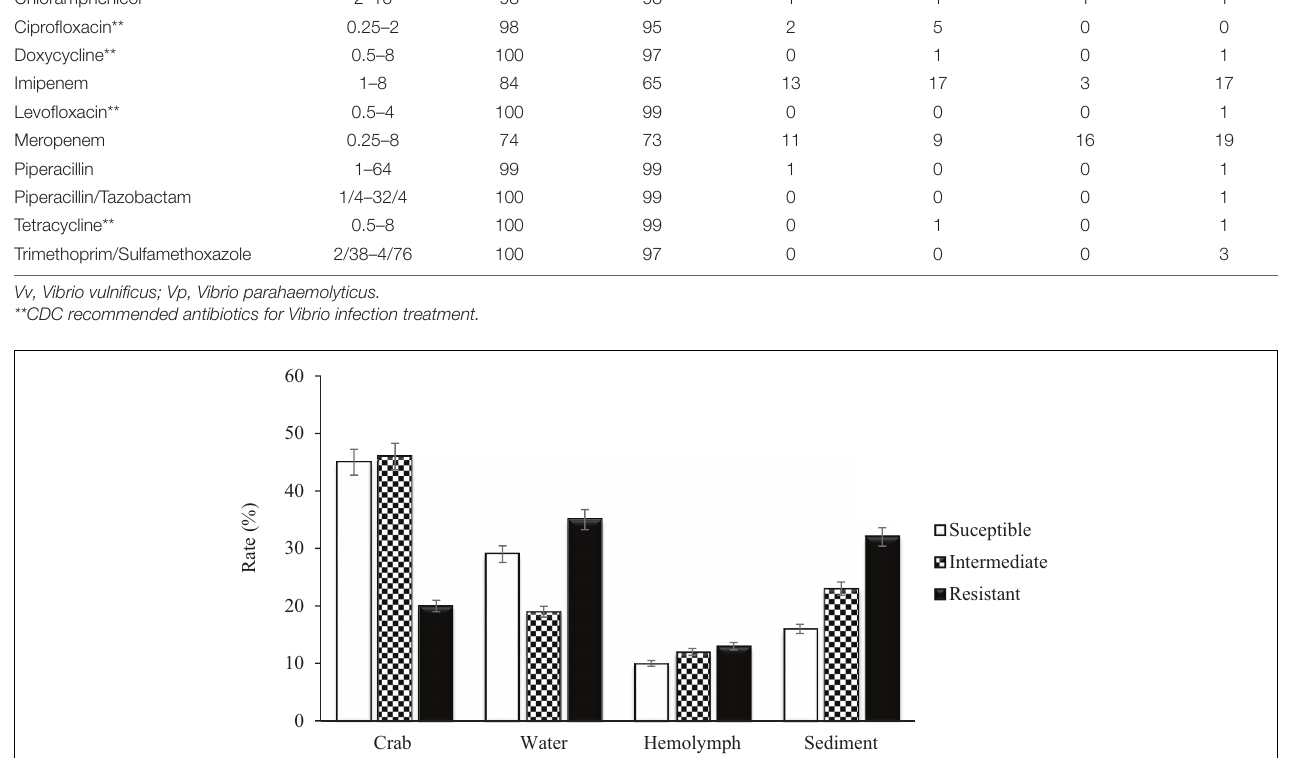
Frontiers in Microbiology |